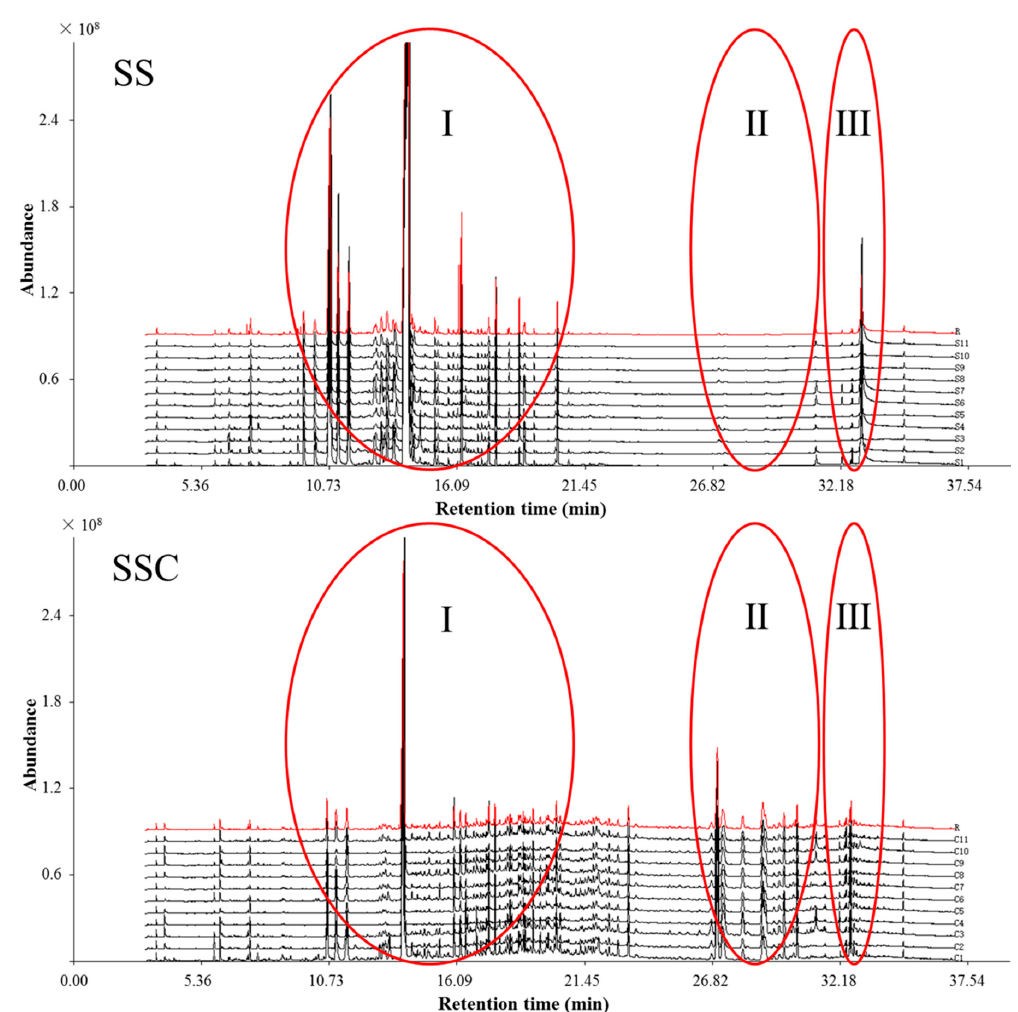
Figure 1. GC-MS fingerprints of Schizonepetae Spica (SS) and Schizonepetae Spica Carbonisata (SSC) samples and their reference chromatograms (R). Table 1. Details of the 11 batches SS and SSC samples and their fingerprint similarities.